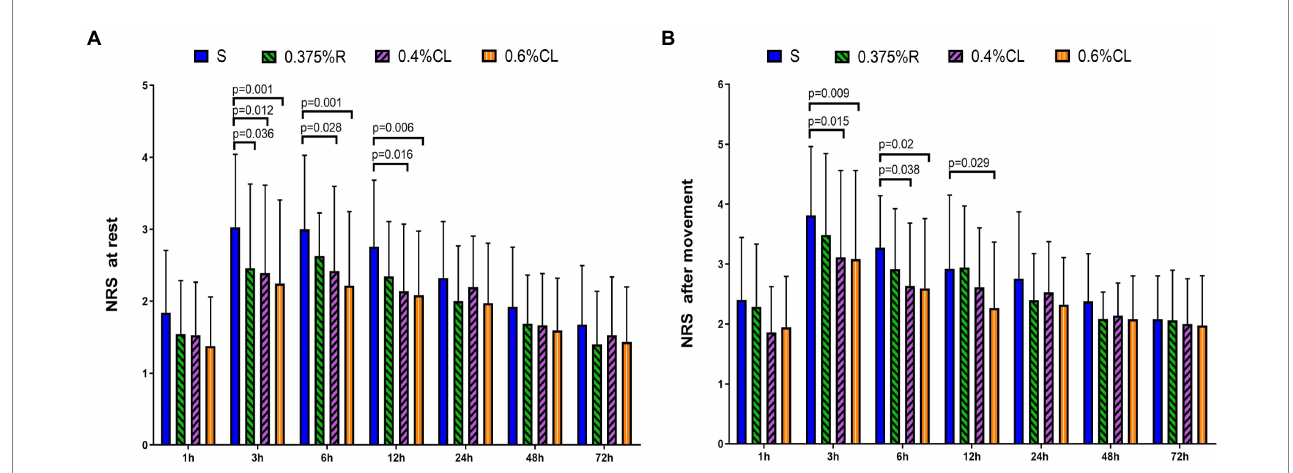
FIGURE 2 Postoperative pain intensity. The numerical rating scale (NRS) score for pain at rest (A) and after movement (B) was documented at 1, 3, 6, 12, 24, 48, and 72 h after surgery. Group S: TAP block with saline; Group 0.375% R: TAP block with 0.375% ropivacaine; Group 0.4% CL: TAP block with 0.4% compound lidocaine; Group 0.6% CL: TAP block with 0.6% compound lidocaine. A bilateral TAP block was performed before the induction of anesthesia. All patients underwent elective gynecological laparotomy under sevoflurane anesthesia. Values are presented as mean (SD). TAP, transversus abdominis